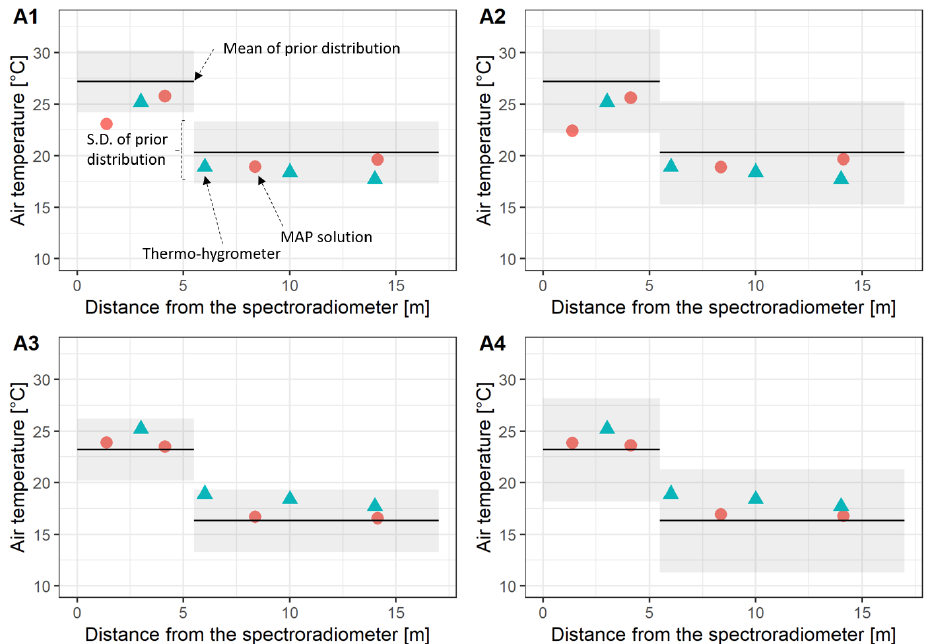
Figure 8. MAP solution in Cases ( A1 – A4 ). The solid line indicates the mean of the prior information x a given by the normal distribution. The mean of the prior information in Cases A1 and A2 were set 2°C higher, whereas those of Cases A3 and A4 were set 2°C lower than the measured value of the thermohygrometer. The shaded region represents the standard deviation of the prior information (i.e., square root of the diagonal component of S a ) set in Table 2.